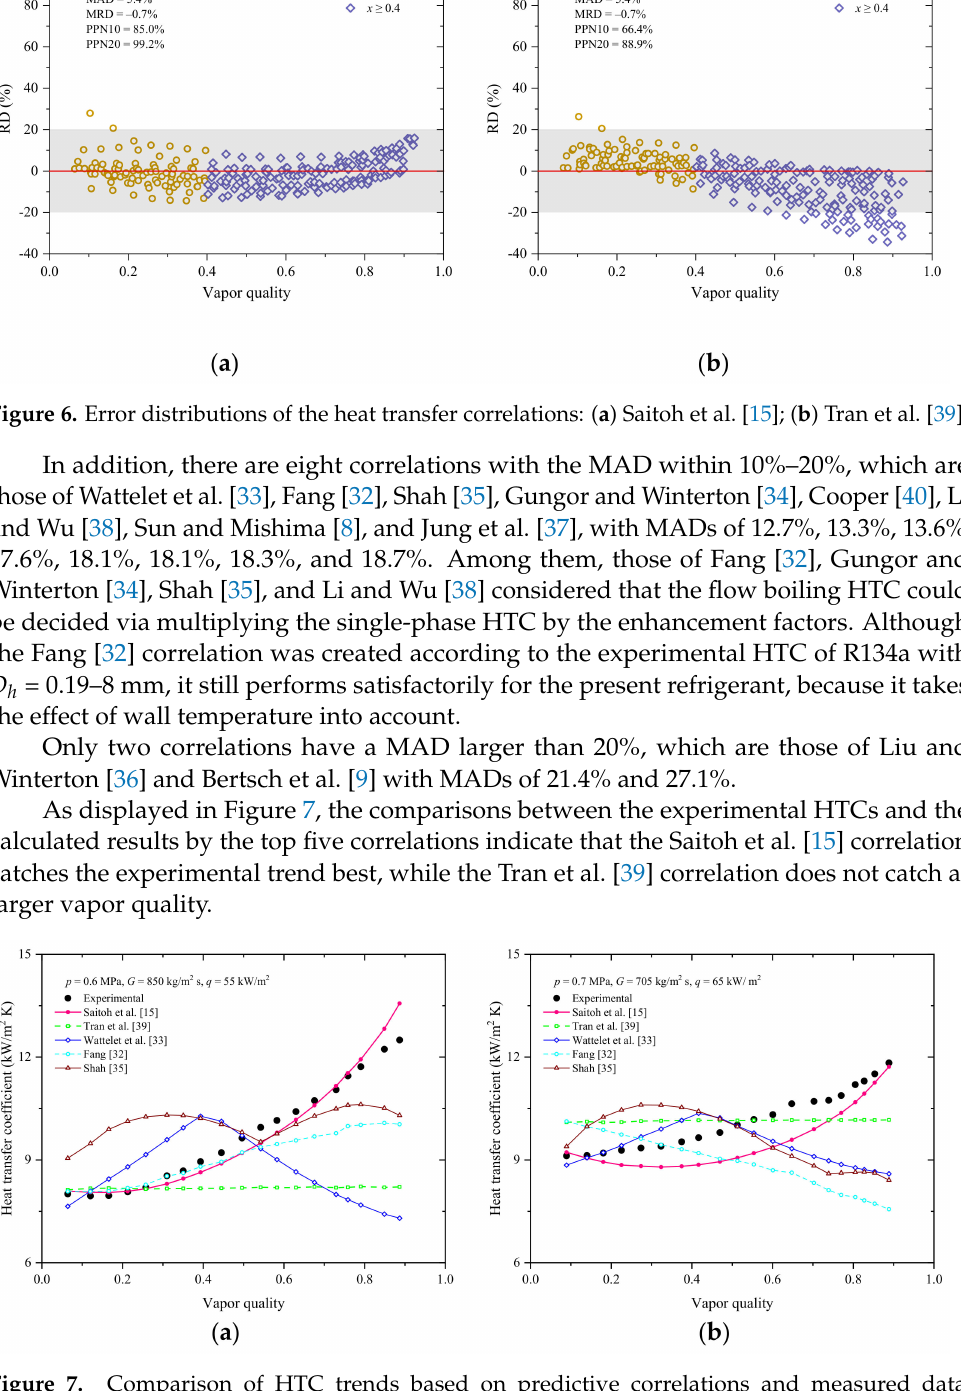
Figure 7. Comparison of HTC trends based on predictive correlations and measured data: ( a ) p = 0.6 MPa, G = 850 kg/m 2 s and q = 55 kW/m 2 ; ( b ) p = 0.7 MPa, G = 705 kg/m 2 s and q = 65 kW/m 2